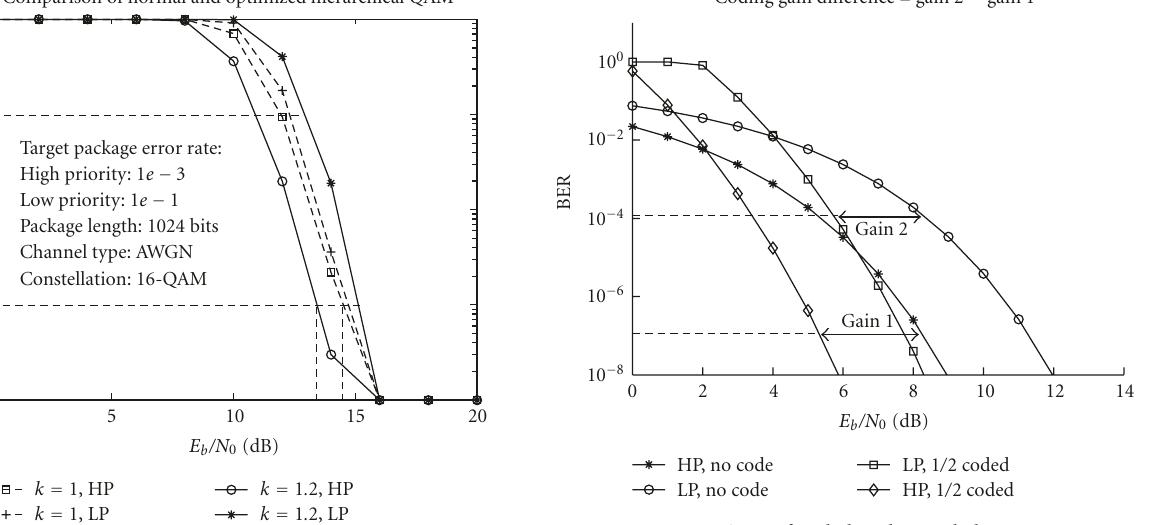
Figure 11: Comparison of coded and uncoded BERs versus SNR per bit (16-QAM modulated). Table 1: Coding gain of BER curve according to space ratio k at BER of 10 − 4 and 10 − 7